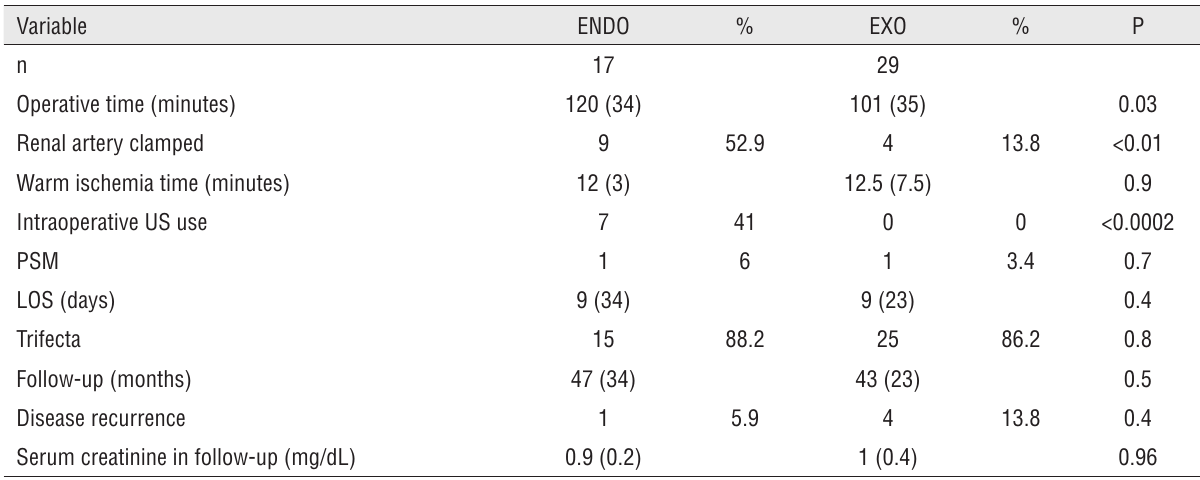
Table 2 - Perioperative and postoperative outcomes for patients having undergone open partial nephrectomy for entirely endophytic or exophytic renal